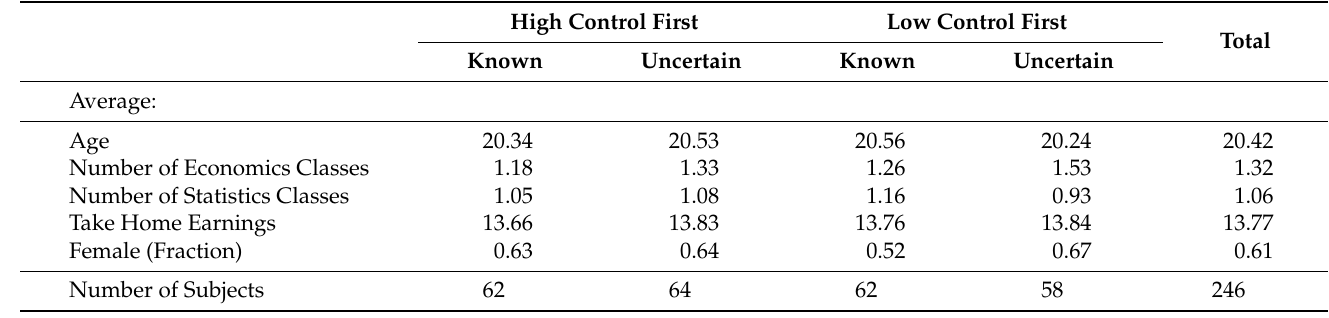
Table 1. Treatment